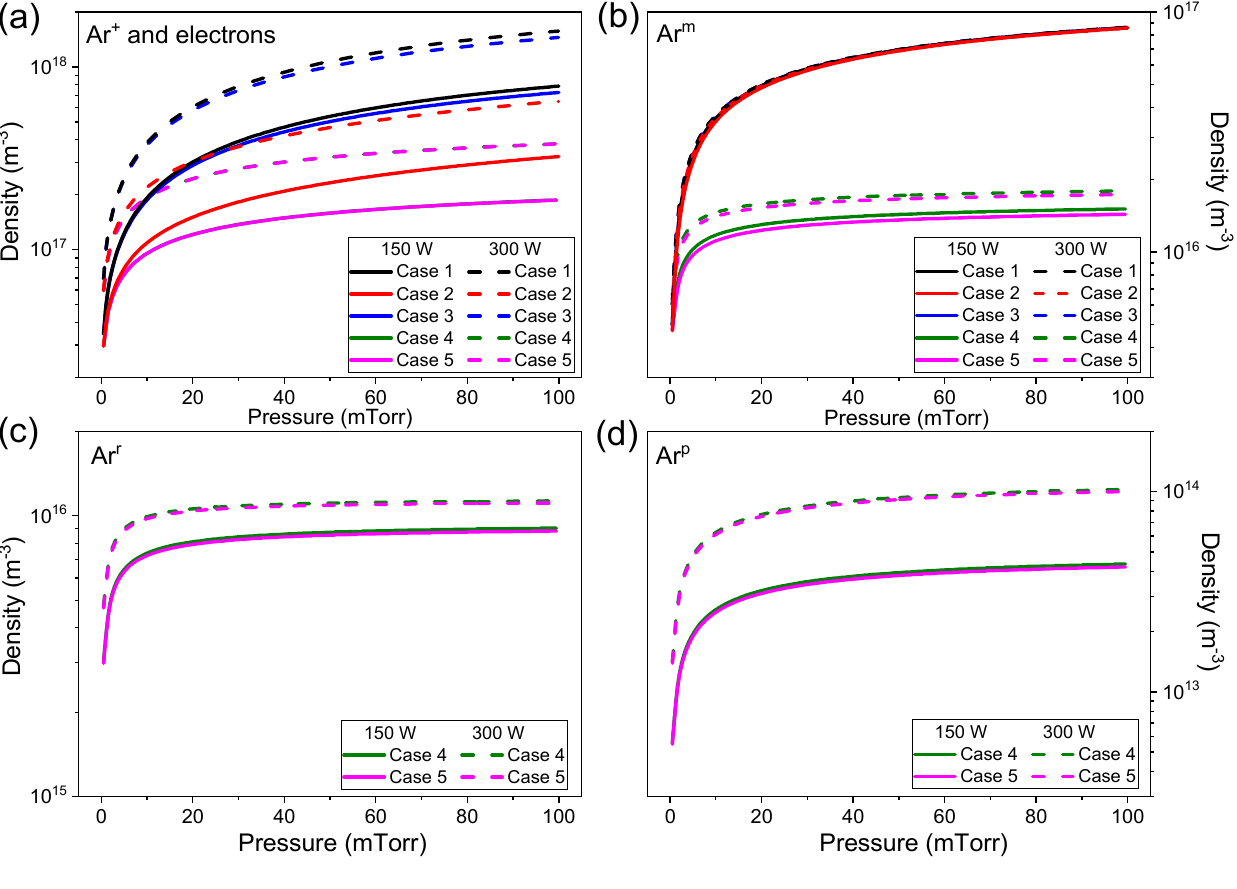
Figure 5. The electron and Ar + ( a ), Ar m ( b ), Ar r ( c ), and Ar p ( d ) species density for all cases as a function of pressure at absorbed power of 300 W. The density of ions and electrons are the same due to the quasi-neutrality. Ar r and Ar p are not considered in the particle balance in cases 1–3. Experimental results from the literature show that the electron density initially increases abruptly with increasing gas pressure up to 10 mTorr and tends to be monotonic for pressures higher than 10 mTorr [22,31,36,48,49]. For the pressure range simulated, the electron density is found to be in the range of 10 16 − 10 18 m − 3 (Figure 5a). All electron densities simulation results are within the range observed in the experiments. The electron temperature is inversely pressure-dependent, decreasing rapidly to 20 mTorr and then varying more smoothly (Figure 4b). This behavior and electron temperature values are in line with experimental measurements [28,29,48,49]. The higher pressure induces more collisions between electrons and heavy particles causing more ionizations, excitations, and elastic collisions [24], consequently, more energy is spent by electrons, decreasing the electron temperature and increasing the collisional energy (see Figures 3 and 4).